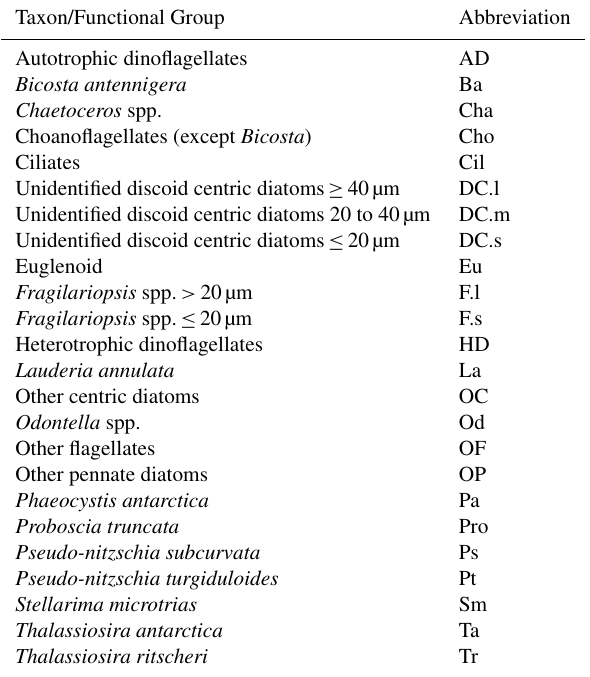
Table 1. Protistan group